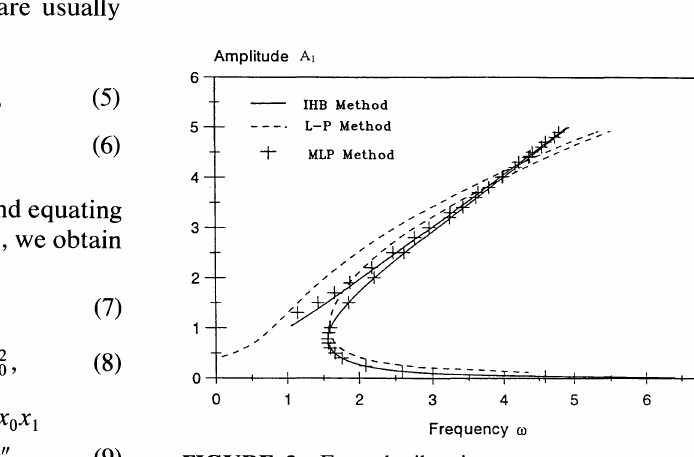
FIGURE 2 Forced vibration response curve w-A] for e = 1, Wo = 1, k z = 0.8, k3 = 1.2, and p =